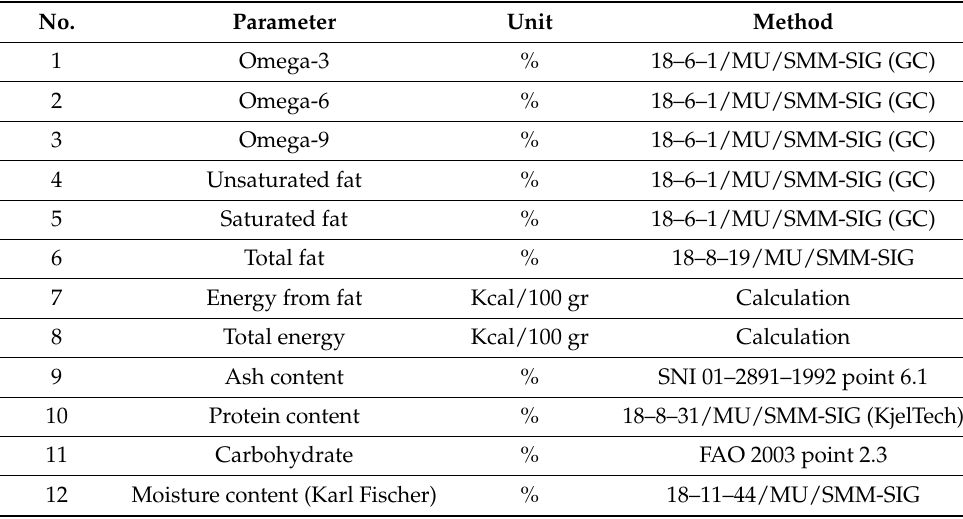
Table 1. The parameters, unit, and method for oil quality